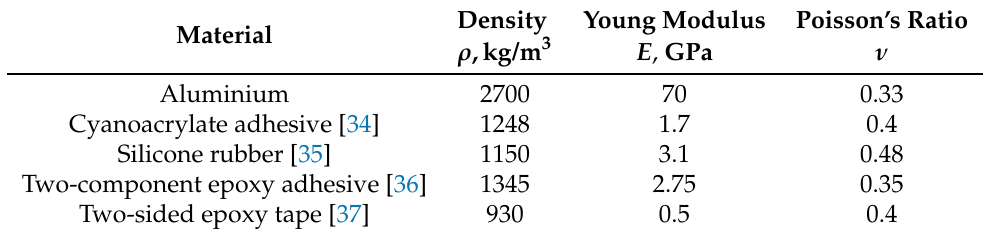
Table 1. Material properties used for